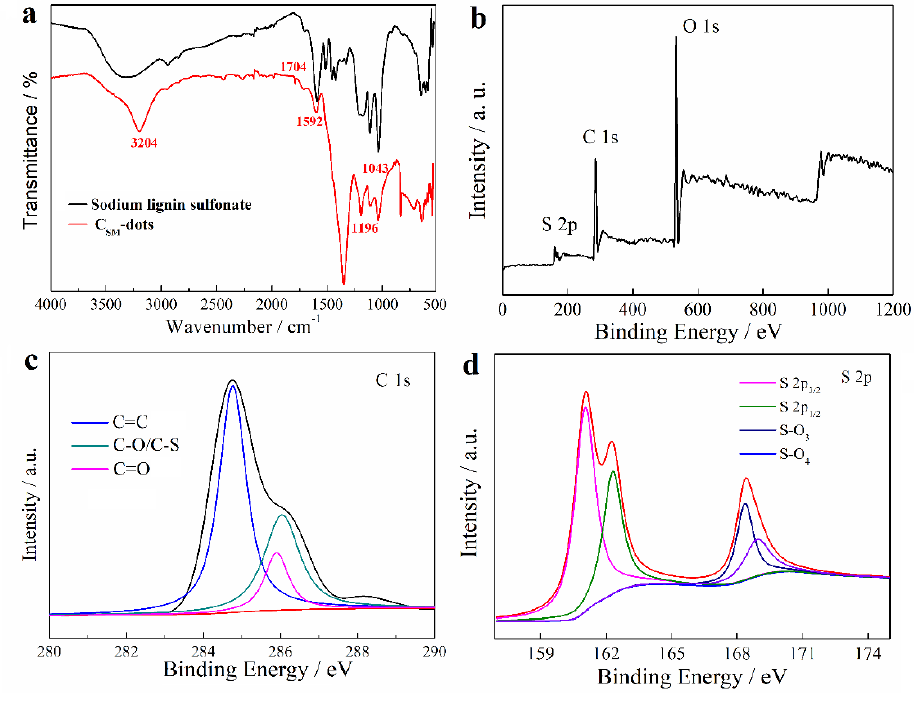
Figure 1. ( a ) FT-IR spectra of lignin and C SM -dots. ( b ) XPS spectrum of C SM -dots. The high − resolution XPS spectra of C 1s ( c ) and S 2p ( d ) in C SM -dots.